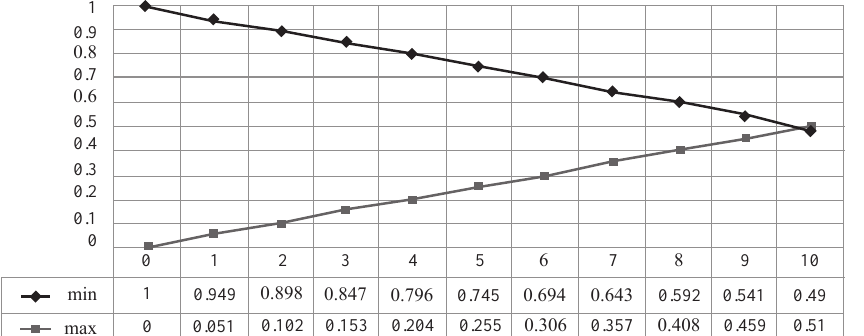
Fig. 3. Example according to formula